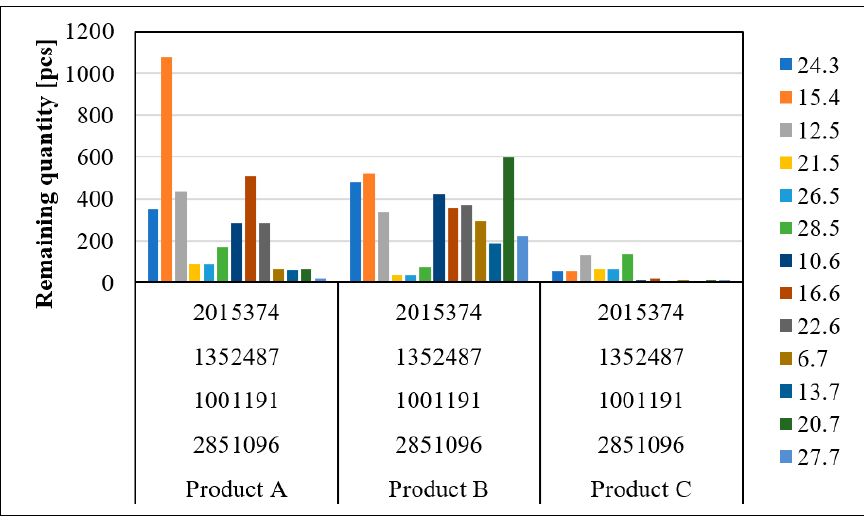
Figure 9. Pivot chart of the specific product model, AAA123.